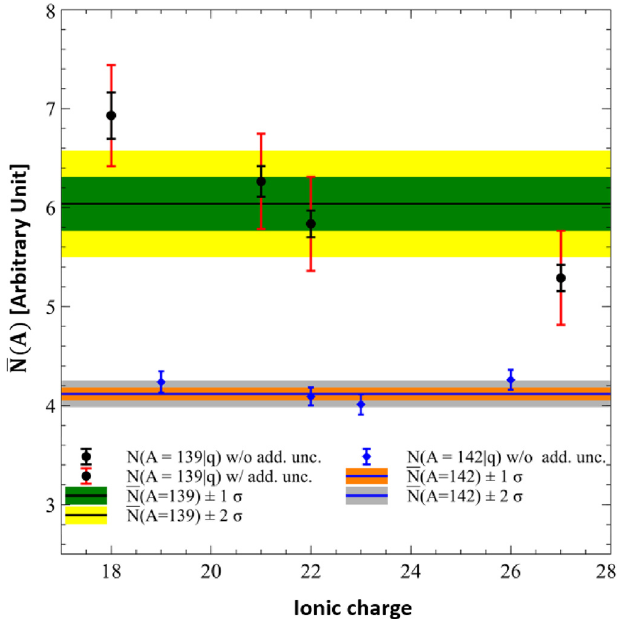
ð A Þ and their mean value N ð A Þ for the masses Fig. 2. Each N q i 139 and 142. The compatibility criteria are met for A = 142 while additional uncertainties (add. unc.) are needed for A =